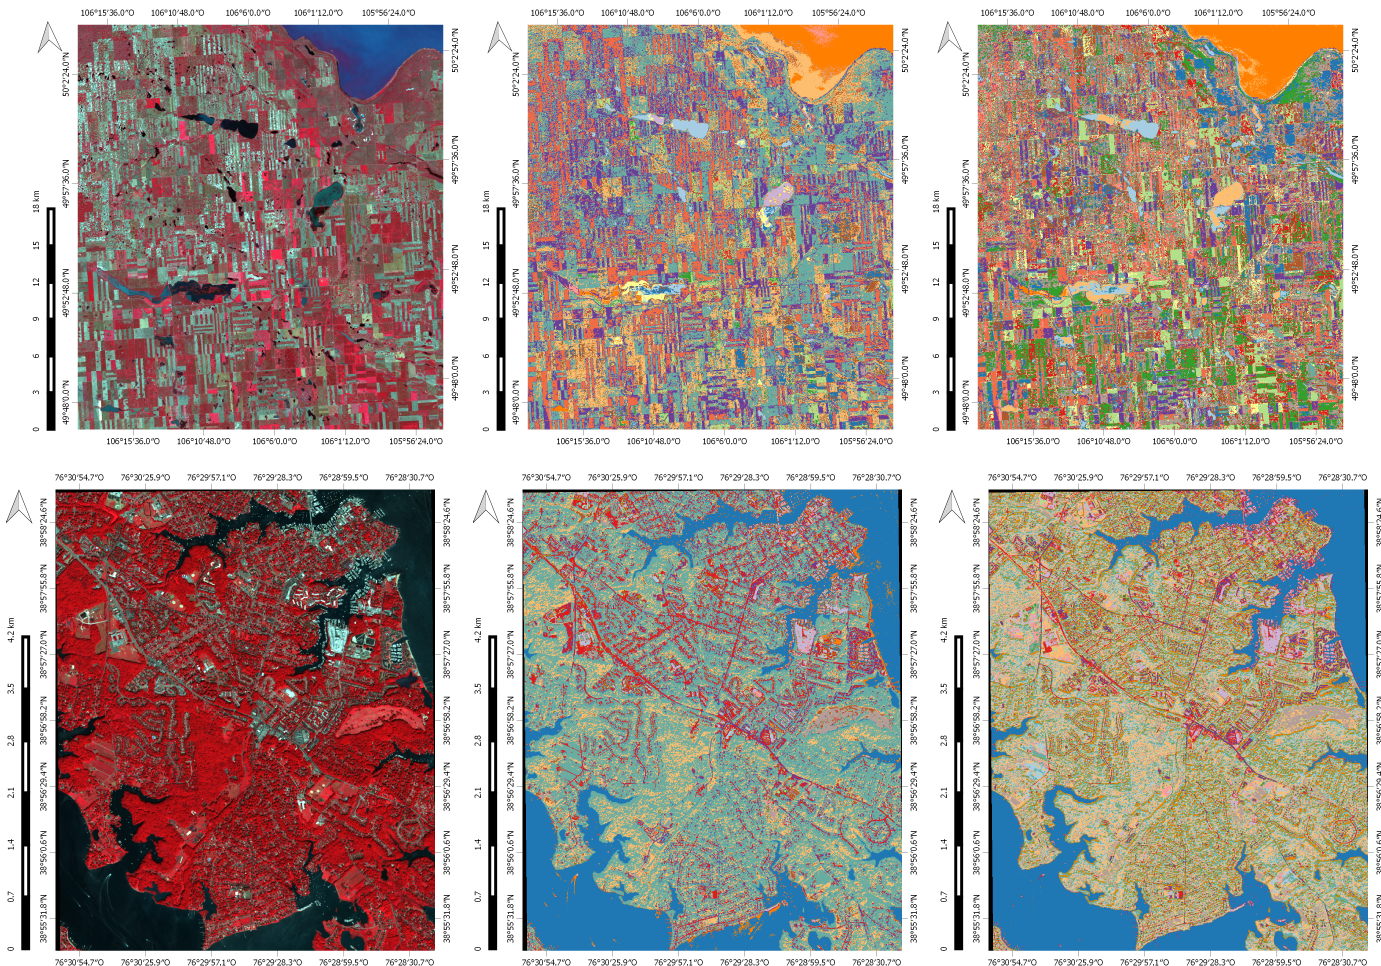
Figure 3. Results for image CANADA2 are displayed in the upper row and for MARYLAND in the lower row. First column: false color composite NIR-G-R. Results for the original method and proposed method for 15 final clusters are displayed in the second and third columns, respectively. Colors have no special